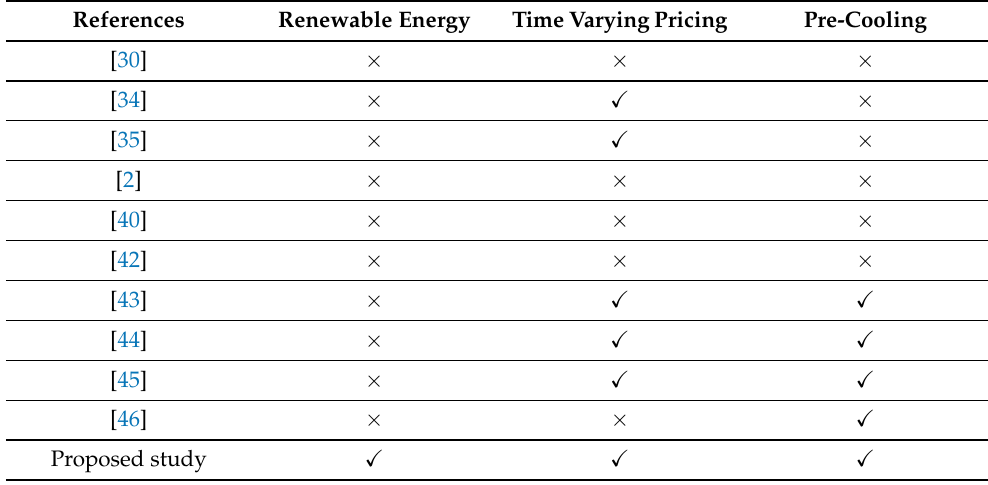
Table 1. Summary of key research papers on optimum energy management for heating/cooling